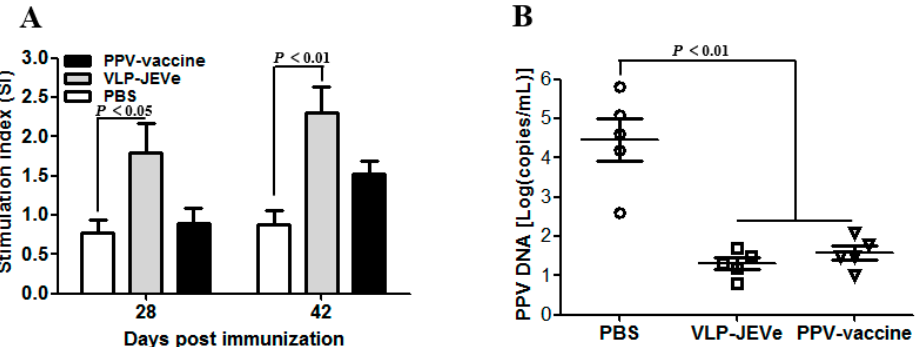
Figure 6. ( A ), Splenocyte proliferation following in vitro stimulation. After immunization with VLP-JEVe, PPV inactivated vaccine, the splenocytes were collected at 28 and 48 days from 3 sacrificed guinea pigs from each group, and then were stimulated with PPV 100 TCID 50 . After 48 h of stimulation, WST-8 was added and the proliferation responses were detected by the stimulated index (SI). ( B ), Protection from PPV virus challenge in guinea pigs. The guinea pigs were challenged with a lethal dose of 5 × 10 6 PFU of PPV at 42 days after primary immunization and monitored for further 14 days. The DNA was extracted from the spleen samples of guinea pigs and the copy number of PPV genomic DNA was determined by quantitative real-time PCR assay. The lower detection limit of the assay is indicated by the dashed line. Data are shown as mean ± standard error. The statistical differences between vaccinated groups and PBS groups were indicated by p < 0.01, p < 0.05.